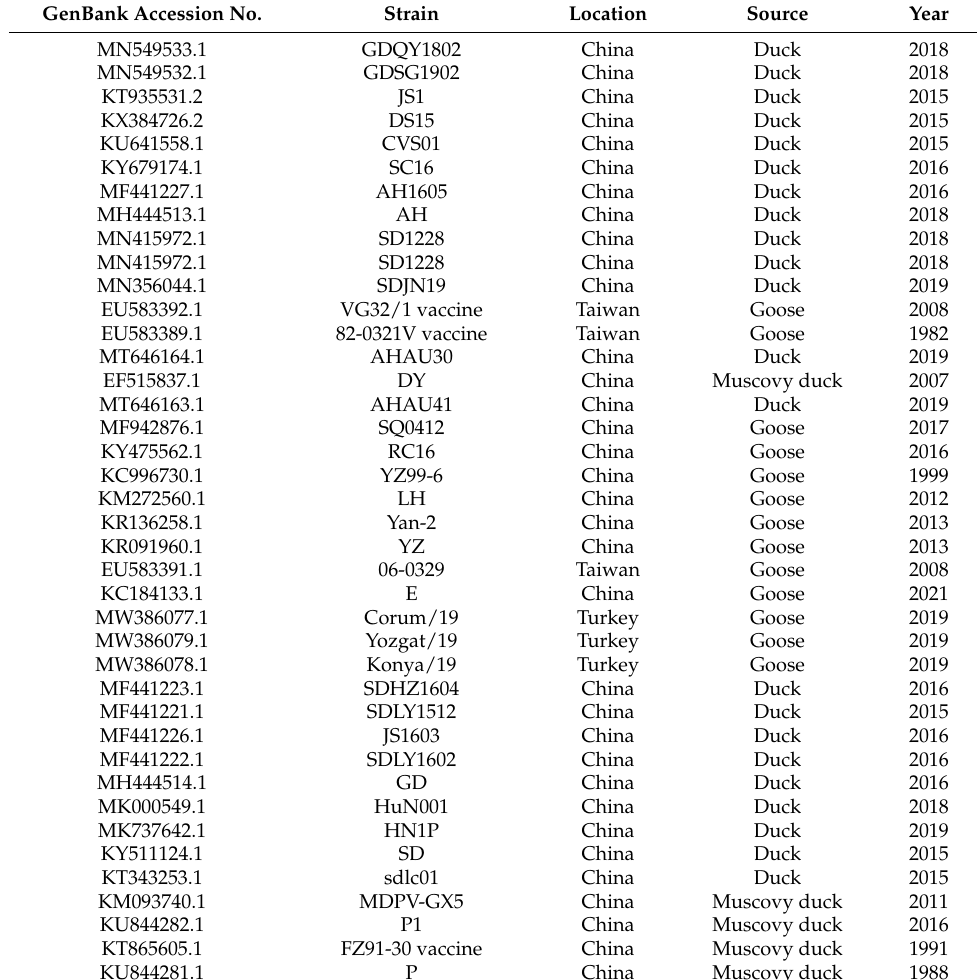
Table 2. Description of waterfowl parvovirus isolates compared in this